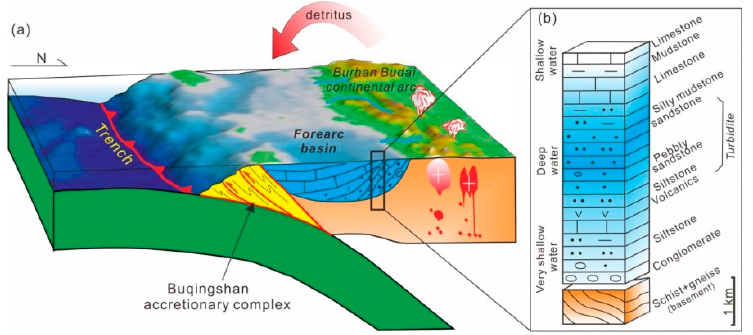
Figure 17. ( a ) Block diagram showing the Hongshuichuan forearc basin and oceanic subduction zone (modified from Frisch et al. [146]); ( b ) Integrated stratigraphic column of the forearc basin deposits during Late Permian to Middle Triassic time.